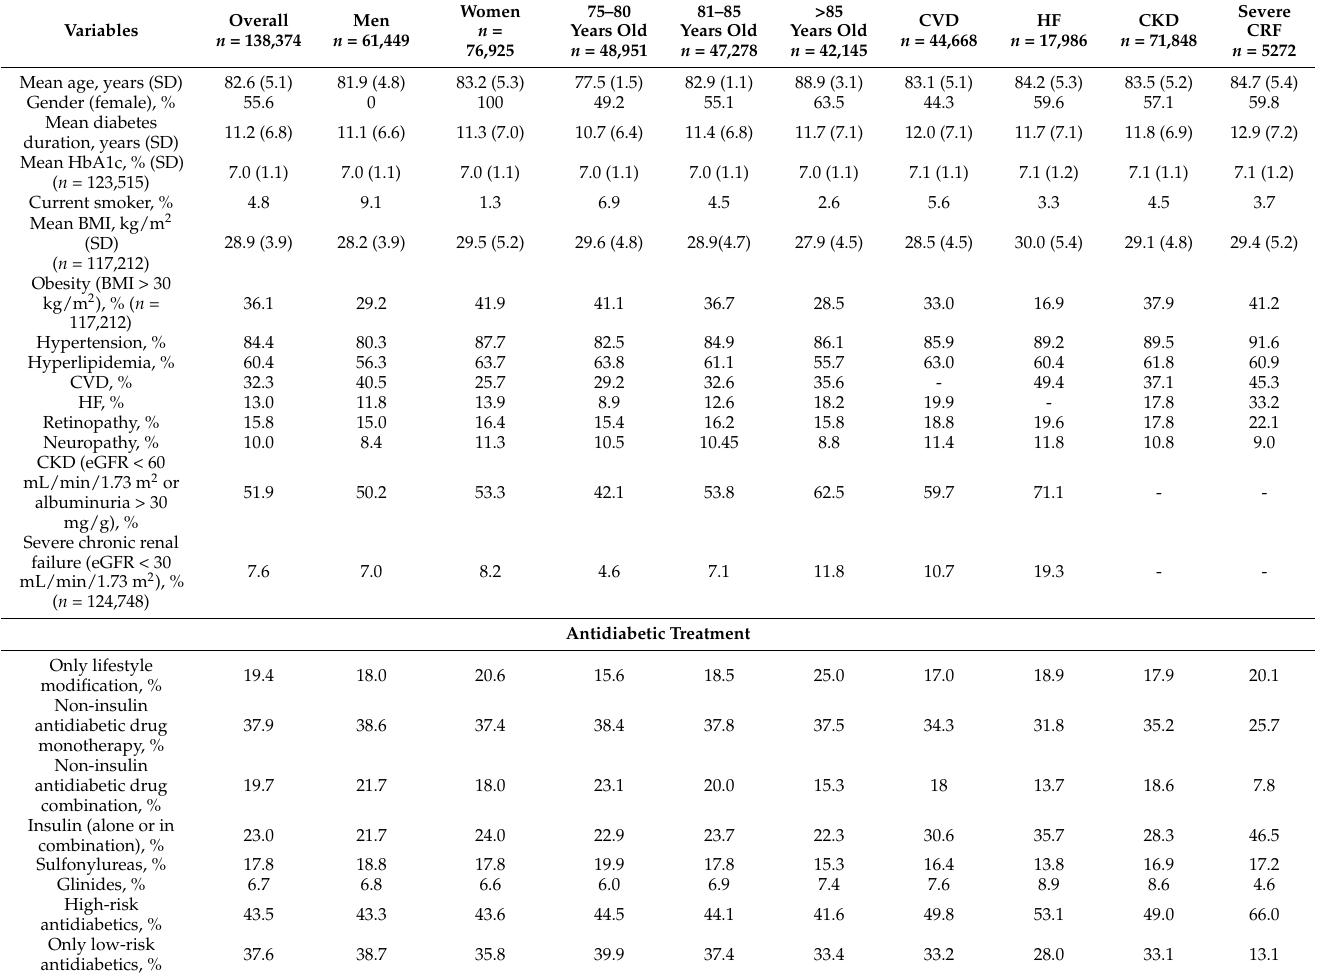
Table 1. Clinical characteristics of patients by sex and age subgroups and the presence of comorbidities.